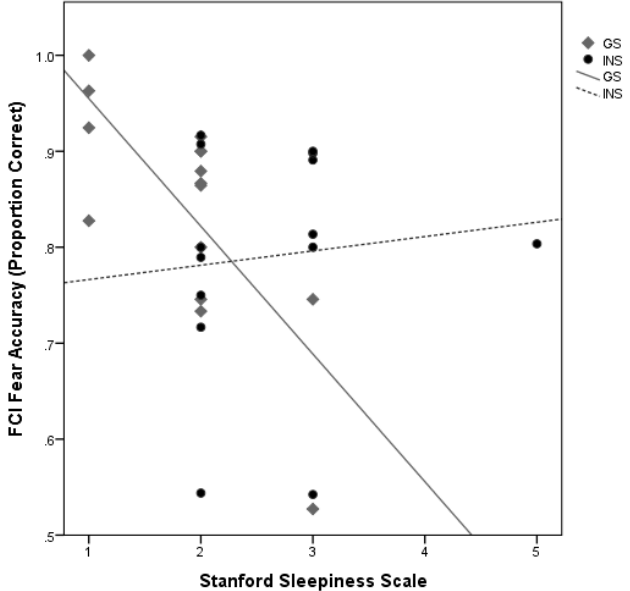
on accuracy for Fearful faces on the FCI, b = 0.15, t = 2.89, p = 0.008. The simple e ff ects analysis of sleepers, b = − 0.13, t = − 3.08, p = 0.005, but not significantly associated in the INS group, b = 0.01, t = 0.55, p = 0.590 (Figure 4).